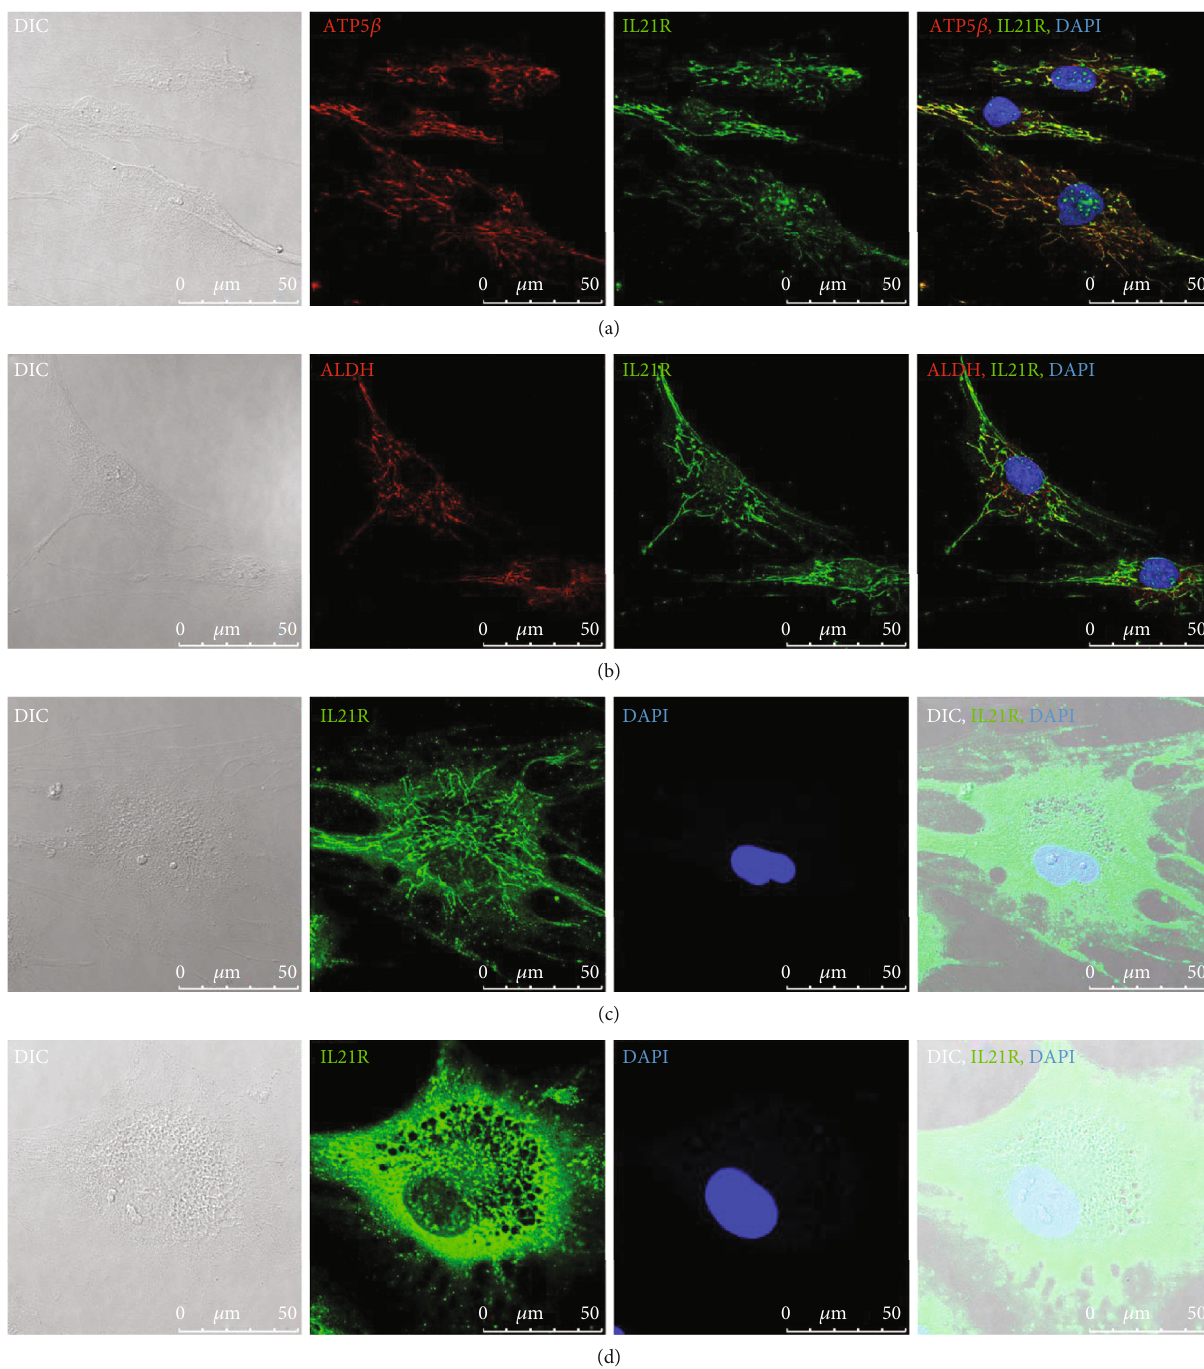
Figure 1: Intracellular localization of IL21R in ADSCs and induced to adipogenesis. Immuno fl uorescence labeling of undi ff erentiated ADSCs using α -IL21R, α -ATP5B, and α -ALDH4A1 in a confocal microscope (a, b). ADSCs were incubated with the primary antibody α -IL21R and the secondary antibody conjugated to Alexa488. ADSCs were incubated with the primary antibody α -ATP5B (Atp5b ATP synthase located in the mitochondria) or ALDH4A1 and the secondary antibody conjugated to Alexa 546. ADSCs were incubated with DAPI for nuclear staining. (a, b) Images were then merged and showed that α -IL21R is colocalized with α -ATP5B and ALDH4A1, indicating that the protein is located in the mitochondria and within cell nuclei. (c, d) Localization of IL21R in premature adipocyte (c) and in adipocyte containing more lipid vesicles (d). Scale bar: 50 μ m. Representative images of the donor TAL36 (a –